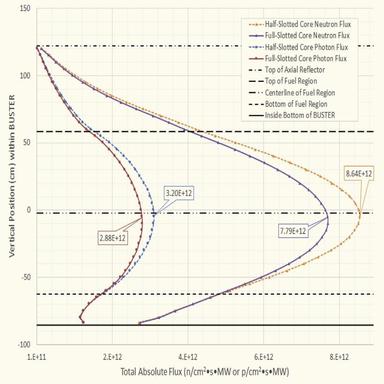
Total Absolute Flux Axial Profile within BUSTER (300 K).